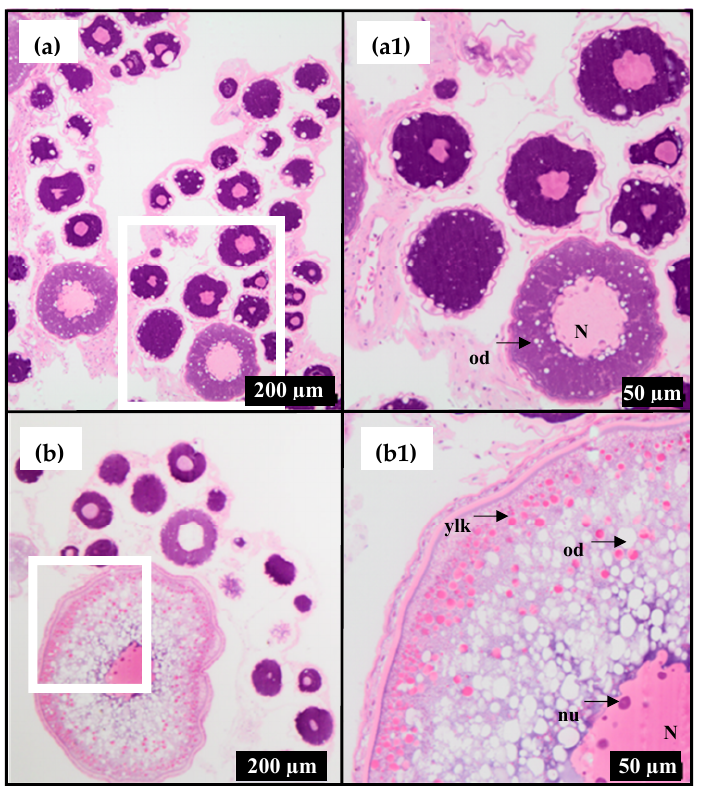
Figure 1. Light micrographs of ovarian tissue from F1 hāpuku (Polyprion oxygeneios) representing the two stages of development used for transcriptome sequencing. Images are from Fish A (Table 1) but are representative of all fish used. White boxes represent areas at higher magnification in adjacent images e.g., a and a1, respectively. ( a ) Pre-vitellogenic ‘early oil droplet’ (mean oocyte diameter of 0.22 ± 0.004 mm); ( b ) early vitellogenic (mean oocyte diameter of 0.40 ± 0.009 mm). Abbreviations: N = nucleus; nu = nucleoli; ylk = yolk platelets; od = oil droplets.